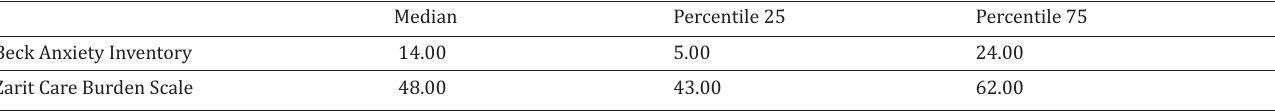
The Total Score Medians of Beck Anxiety Inventory and Zarit Care Burden Scale